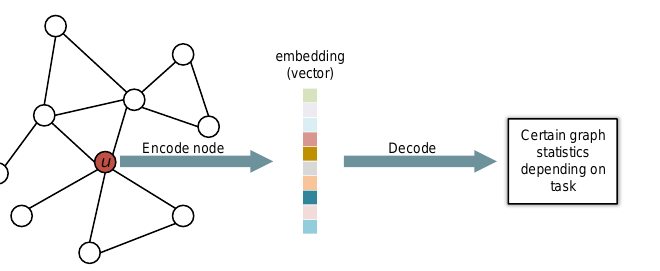
Figure 4. The encoder–decoder framework. The encoder is a function that maps nodes to low- dimension vectors (i.e., node embeddings). The decoder reconstructs certain graph statistics from the node embeddings that generated by encoder, e.g., predicting u ’s category on node classification task.